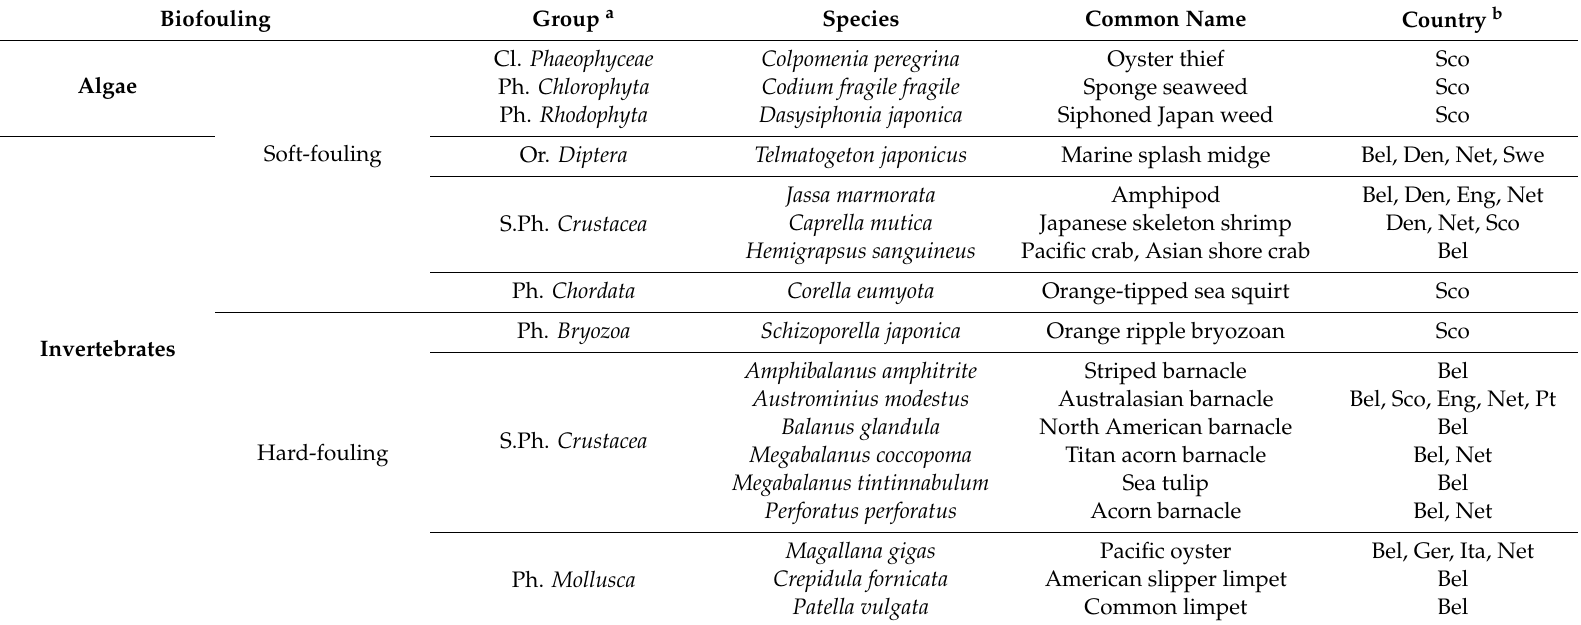
Table 5. Non-native species identified in the literature reviewed and countries where they were